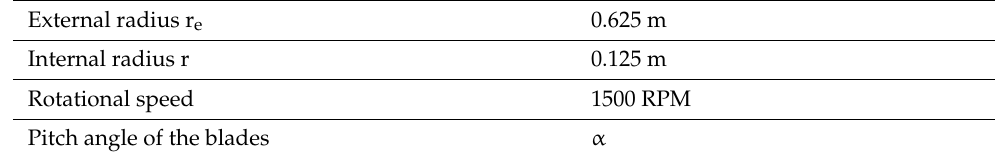
Table 2. Parameters of the fan.